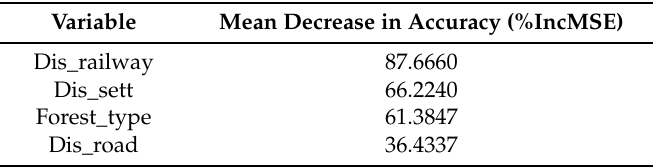
Table 3. Variables included in the final model using Random Forests, in descending order of importance based on mean decrease in accuracy from the complete data set.